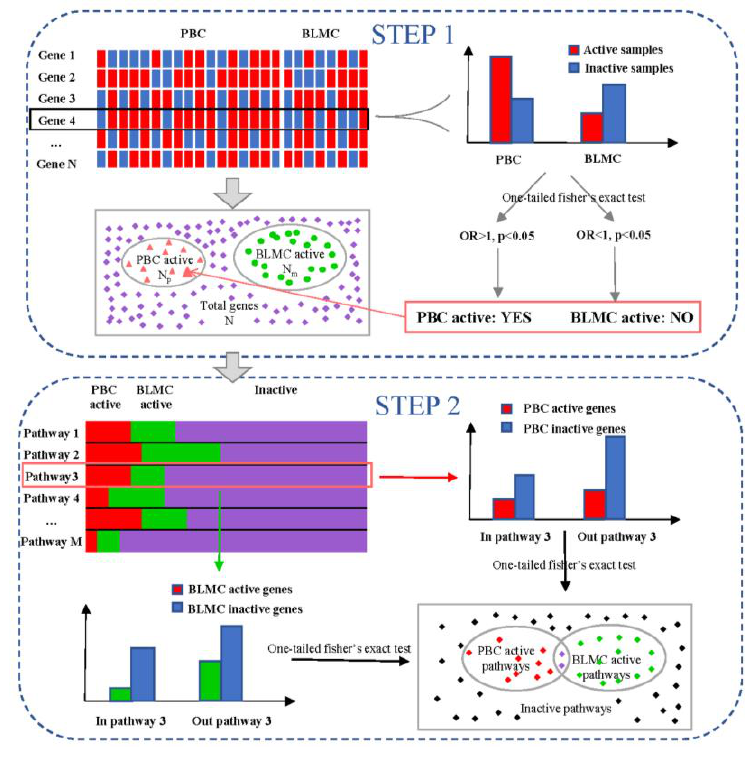
Figure 1. Flowchart. Figure 1.